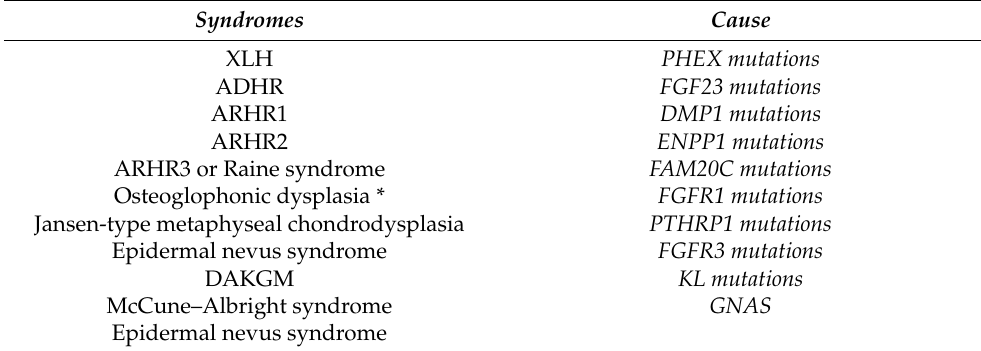
Table 2. Hypophosphatemic syndromes of genetic origin associated with elevated levels of fibroblast growth factor 23